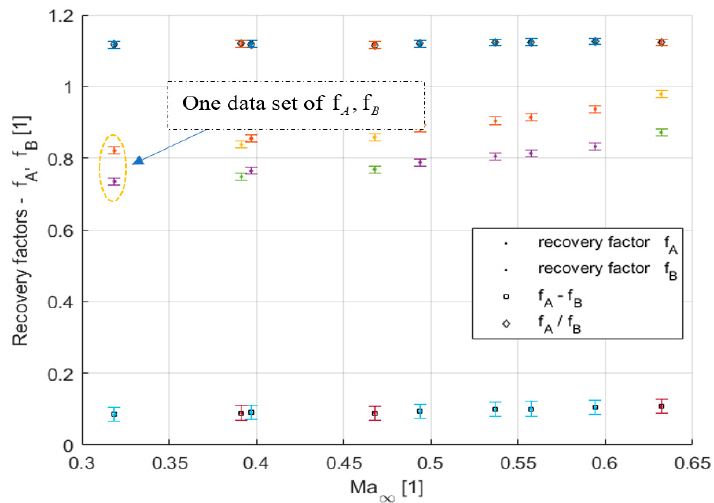
Figure 5. Results of the experimental investigation of the recovery factors of both temperature sensors of a multi-element temperature probe designed for airspeed measurement.